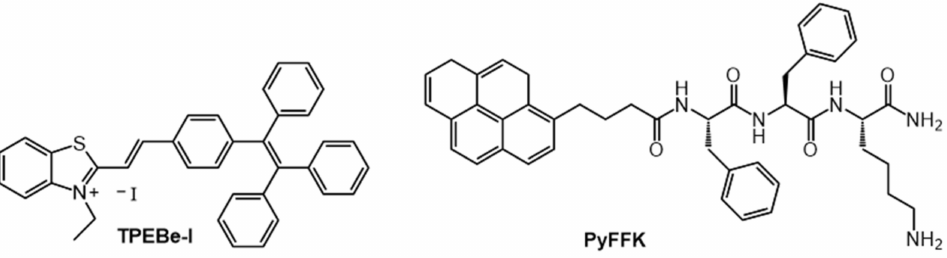
Figure 7. Molecular structures of TPEBe-I and